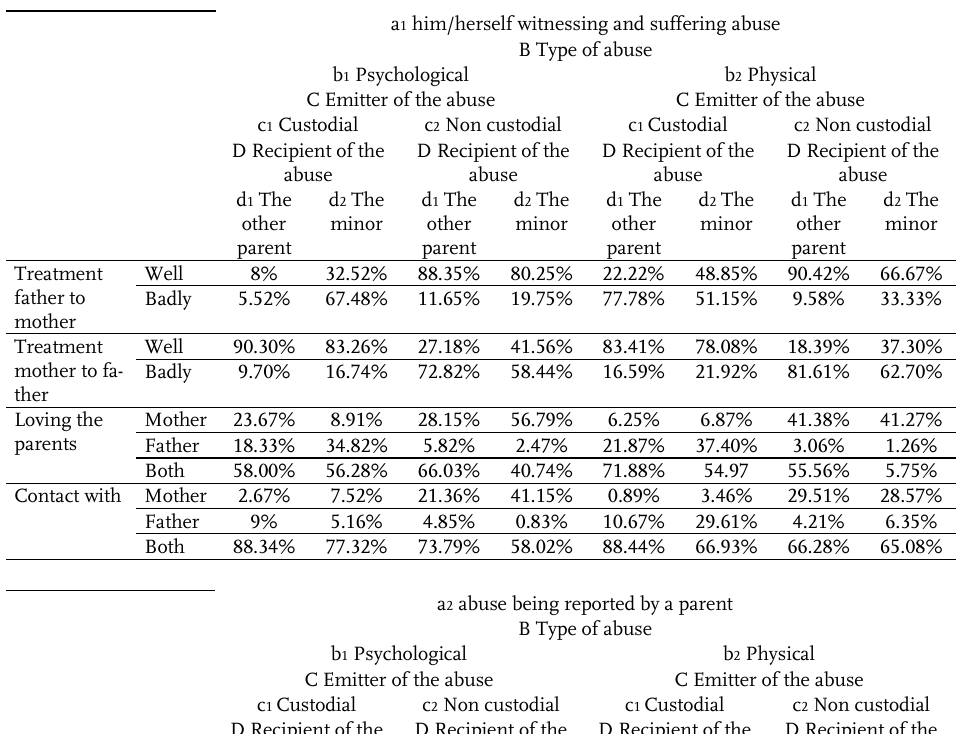
Table 1 : Influence of the observation of the aggression, of the type of violence, of who emits the violence and of who it emits it in the desire of contact of the minors in the